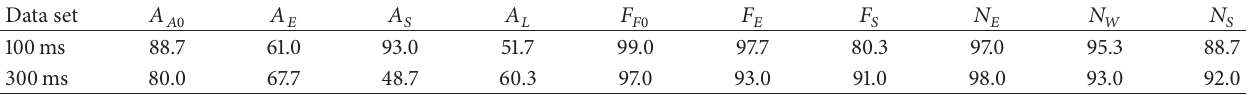
Table 3: Predictive accuracy of partition components and MoE (in %) at the 90th second of simulated time. Data